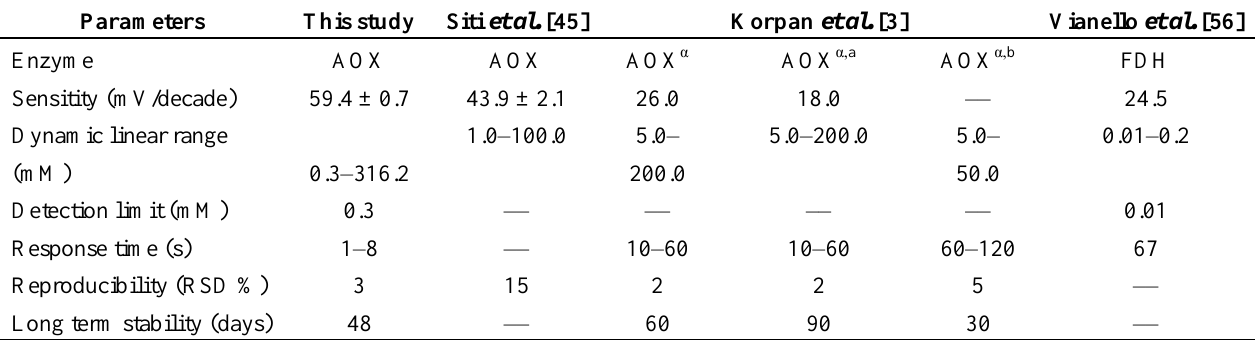
Table 8. Comparison between AOX-poly(nBA-NAS) microspheres based biosensor and reported potentiometric formaldehyde